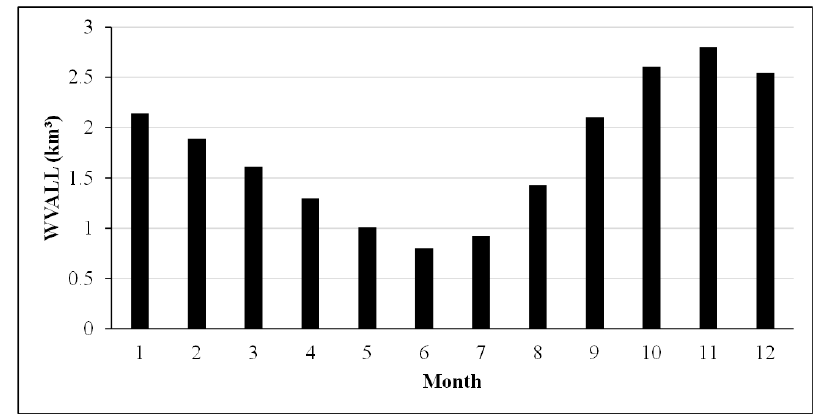
Figure 21. Monthly average WVALL of the SPLC from 1992 to 2016.